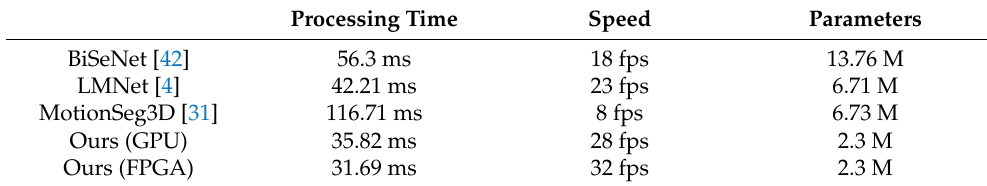
Table 5. Run-time performance on the SemanticKITTI validation set.